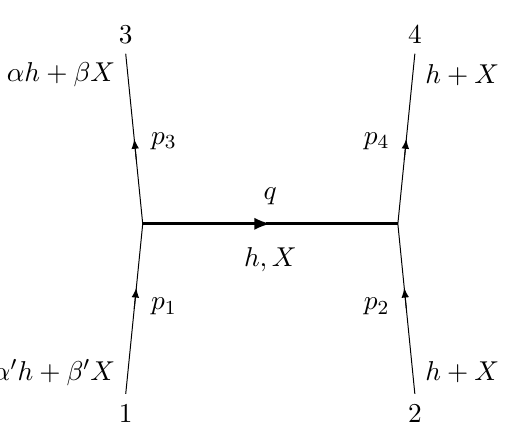
Figure 5 . Bounds from interference in D = 4. In-states are linear combinations of massive higher spin particle X and the graviton h